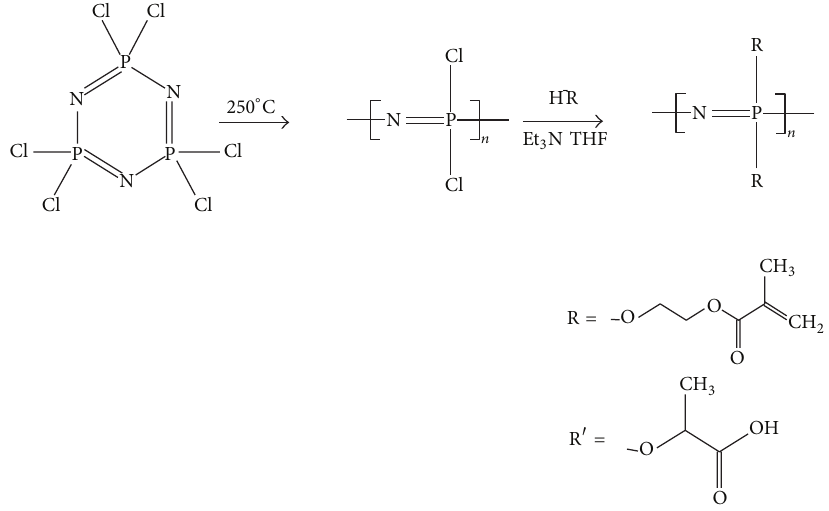
Figure 1: Synthesis by substitution of